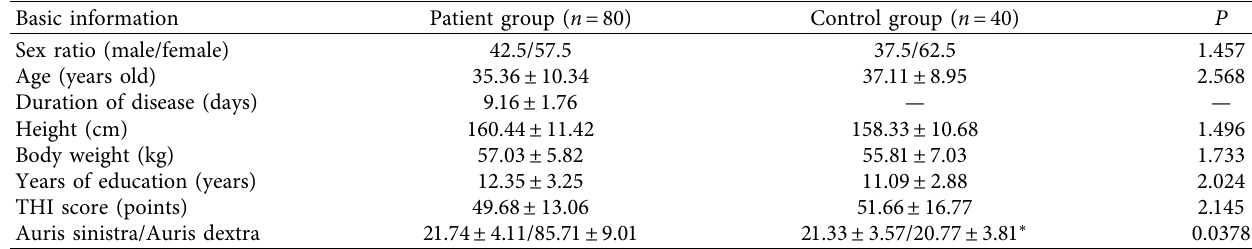
Table 1: Comparison of basic data of medical staf between the two